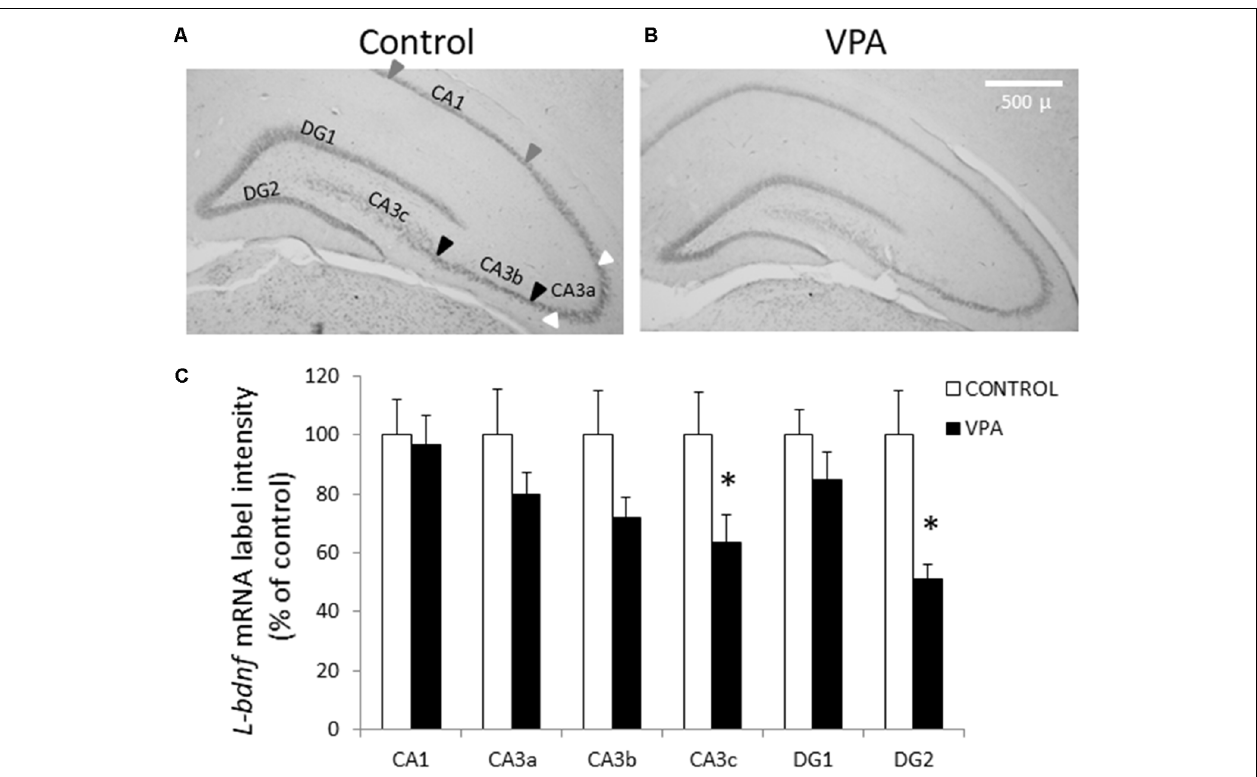
FIGURE 3 | Prenatal VPA treatment decreases L-bdnf mRNA level in the inferior blade of DG and in the polymorphic layer of the CA3 hippocampal region. Representative microphotographs showing ISH labeling, using a specific riboprobe to detect L-bdnf transcripts in PN30 hippocampus from controls (A) and prenatally VPA-treated rats (B) . ISH label intensity of digital microphotographs from control and experimental animals was analyzed in the different layers of hippocampal subfields and expressed as percentage of controls (C) . The data represent the mean ± SEM of L-bdnf mRNA label intensity. Controls are represented by white bars and VPA-treated animals are represented by black bars. ∗ p < 0.05, U -test. n = 8 for control and VPA-treated rats. Scale bar, arrowheads and hippocampal areas are the same as described in Figure 2